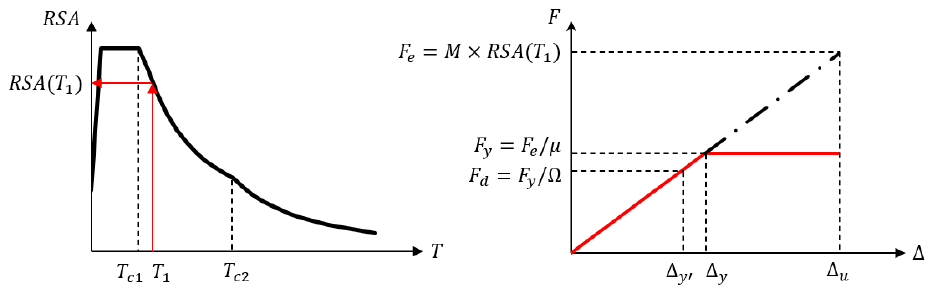
Figure 2. Force-based seismic design approach.